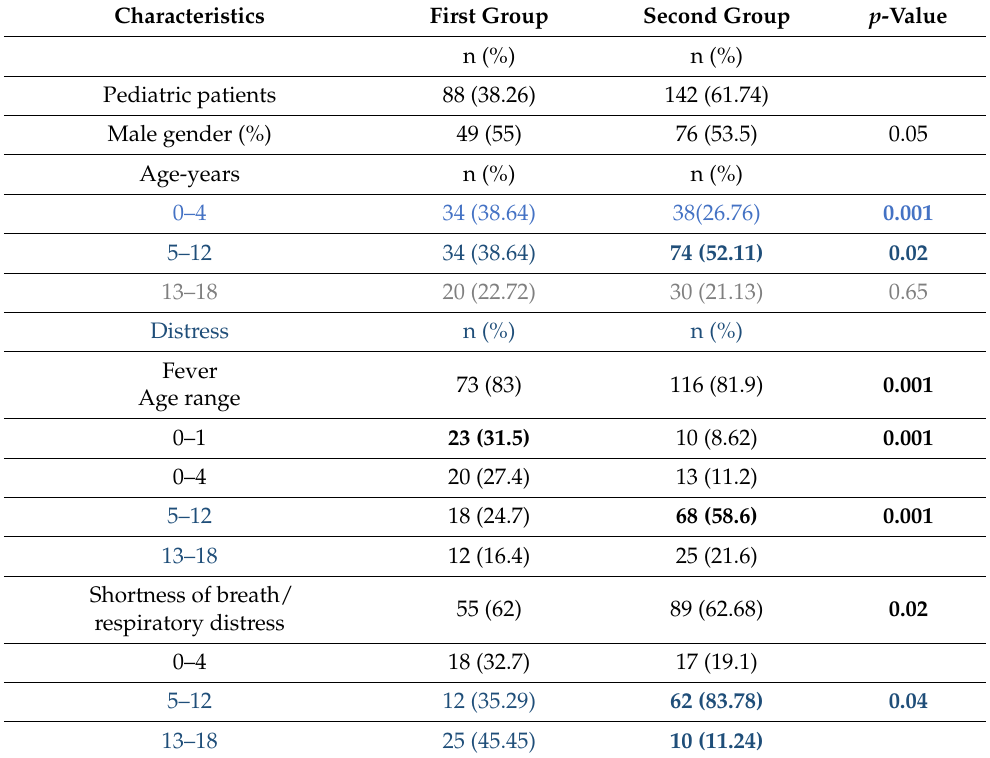
Table 2. Epidemiological and clinical characteristics of pediatric patients, between the 1st and 2nd groups and in different age ranges (0–1, 0–4, 5–12, 13–18 years of age). Data are shown as numbers, n (%), and p -values were calculated for both groups and were compared using the Mann- Whitney U test. A two-sided p -value < 0.05 was considered